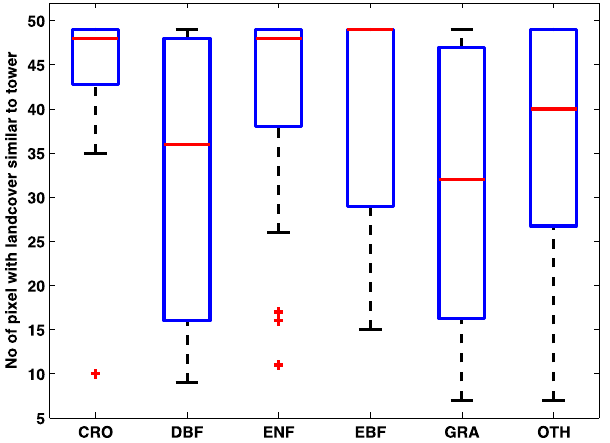
Fig. 2. Box plots showing the number of pixels in 7-by-7 pixel win- dows centered at each tower site whose land cover class matched the land cover corresponding to the tower sites (maximum agree- ment = 49). The pixel land cover classes were obtained from the MODIS Land Cover Dynamics Product and land cover at each tower site was obtained from the information provided in the La Thuile data set. Red line marks median and cross indicates outliers ( > 3 standard